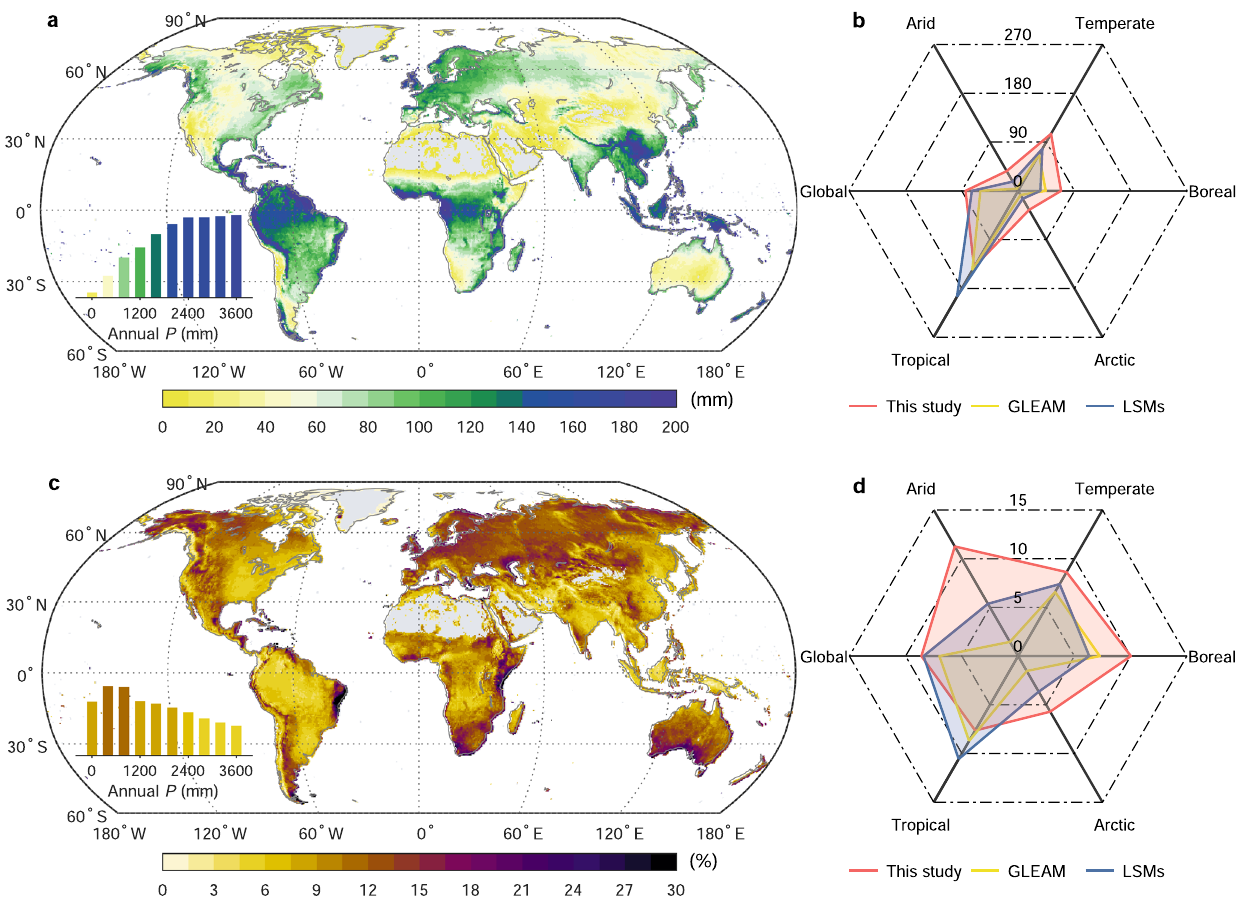
Fig. 4 | Spatial variations in annual mean intercepted rainfall ( E i ) and its frac- tionoftotalrainfall( E i / P ). Spatialpatternsrepresentmulti-yearannualmean E i ( a ) and E i / P ( c ) during 2000 – 2020, with the inset histogram showing the mean value across precipitation ( P ) gradients. The radar plots on the right compare the E i ( b )